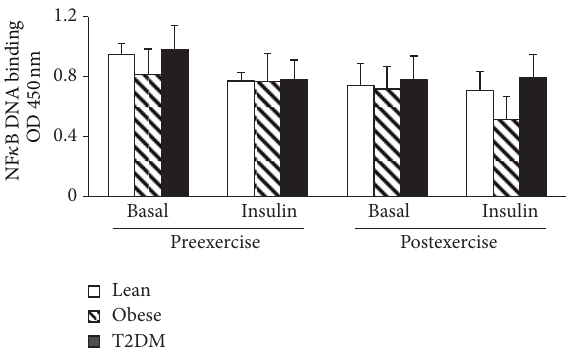
Figure 5: NF 𝜅 B activity. NF 𝜅 B DNA binding was measured in PMNC from 17 lean, 8 obese, and 11 T2DM individuals at the basal state (b) and at the end of the insulin clamp (i) before (pre) and after (post) exercise training. Data are means ±